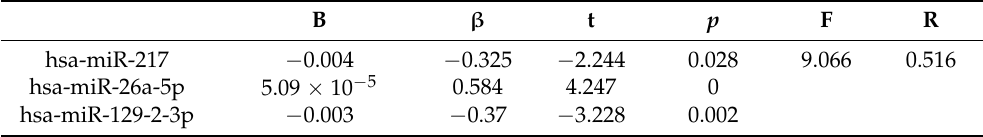
Table 1. Association of the expression levels of three miRNAs with DR severity via regression